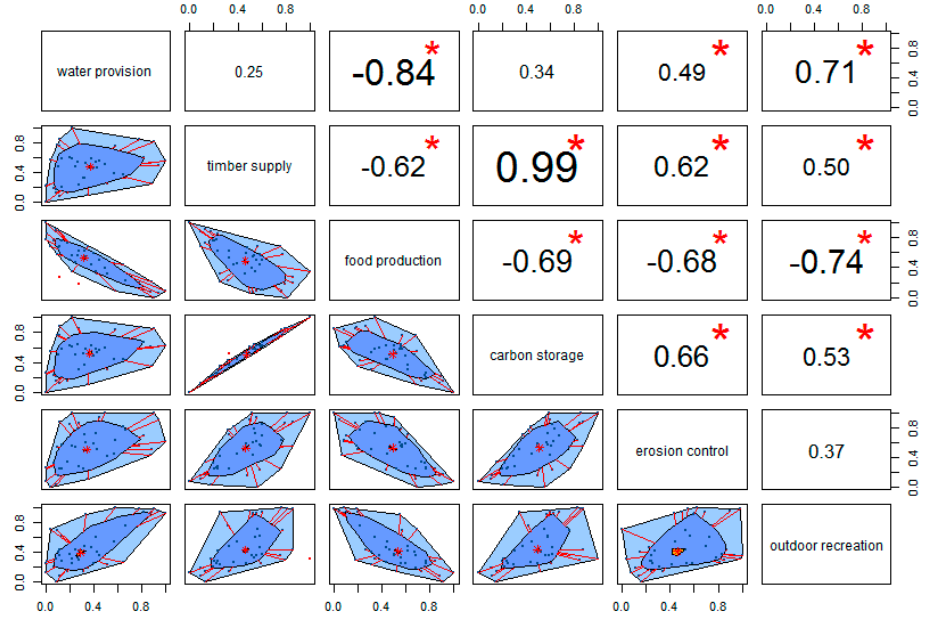
Figure 4. Interaction for pairs of ecosystem services showing correlation coefficients r and bagplots; asterisks indicate a significant correlation ( p -value < 0.001).